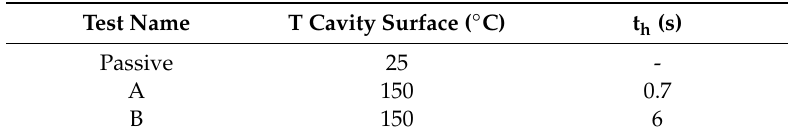
Table 1. Operating conditions adopted during the injection molding experiments Passive, A and B (T = temperature at the cavity surface; t h = cavity surface heating time).